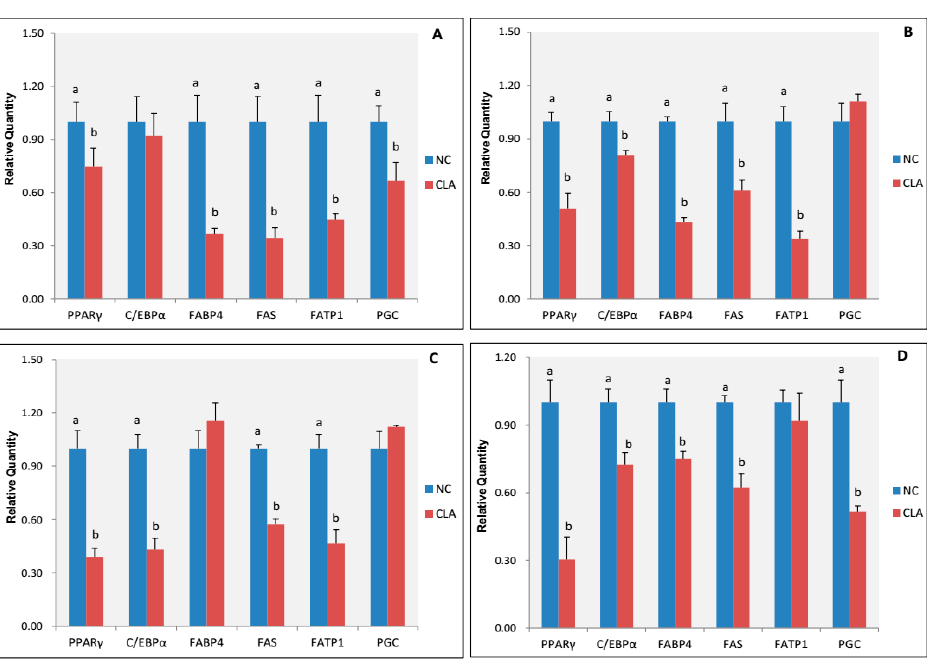
Figure 5. Expression level of adipogenic transcription factors and adipocyte genes in subcutaneous adipose tissues and abdominal adipose tissues of pigs. NC: control group; CLA: CLA treatment group. ( A ) dorsal subcutaneous adipose tissue at 30 days old; ( B ) dorsal subcutaneous adipose tissue at 90 days old; ( C ) dorsal subcutaneous adipose tissue at 240 days old; ( D ) abdominal adipose tissue at 240 days old. Upper letters (a, b) on bars denote significantly different expression levels in the same gene ( p <0.05).